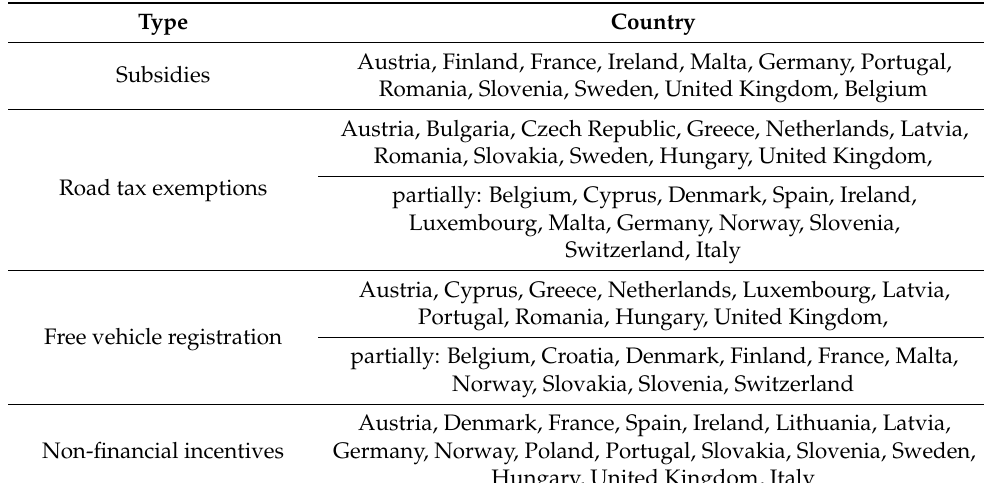
Table 2. Benefits, incentives, and privileges for EVs in different European